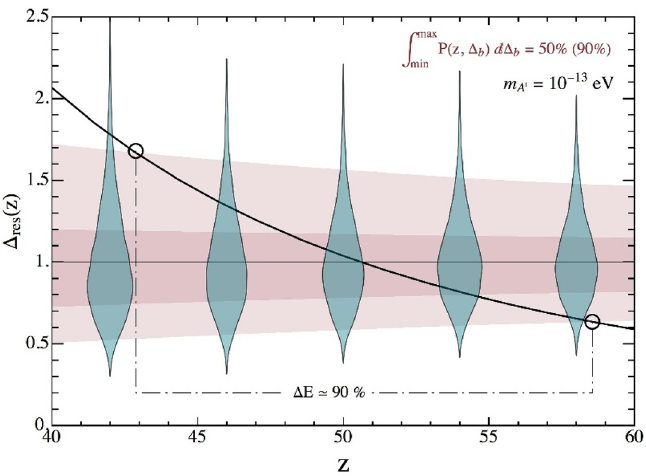
Figure 2 . Evolution of (cid:1) res ( z ) (black line) for a dark photon with m A 0 = 10 (cid:0) 13 eV. We plot the log-normal overdensity PDF (blue regions) at z = 42 ; 46 ; 50 ; 54 ; and 58, and we illustrate using red bands the intervals containing 50% and 90% of the PDF (assuming equal weight in each tail). Identifying the intersection of the (cid:1) res line with the edges of a particular band, one can approximate the fraction of energy injected in a particular redshift